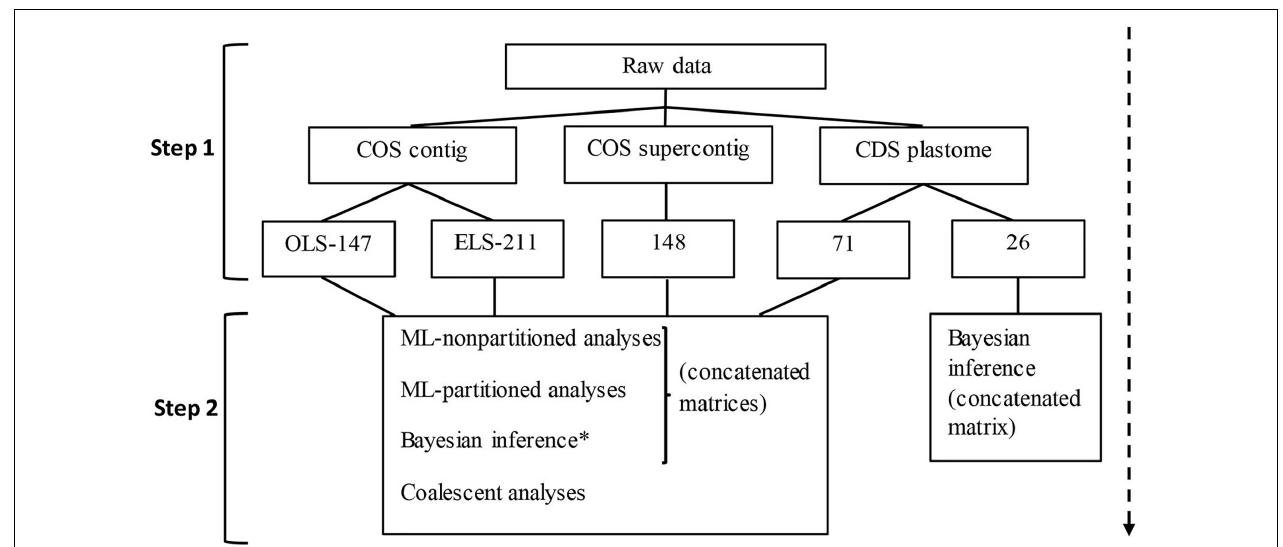
FIGURE 2 | Flowchart summarizing the data assemblage (step 1) and phylogenetic analyses (step 2) in this study. Numbers in the third row correspond to the number of loci in concatenated matrices and the number of gene trees used for coalescent analyses. ∗ only conducted for the OLS-147 dataset; COS, [nuclear] conserved ortholog set; CDS, [protein] coding sequences; OLS, original loci set; ELS, enlarged loci set; ML, maximum